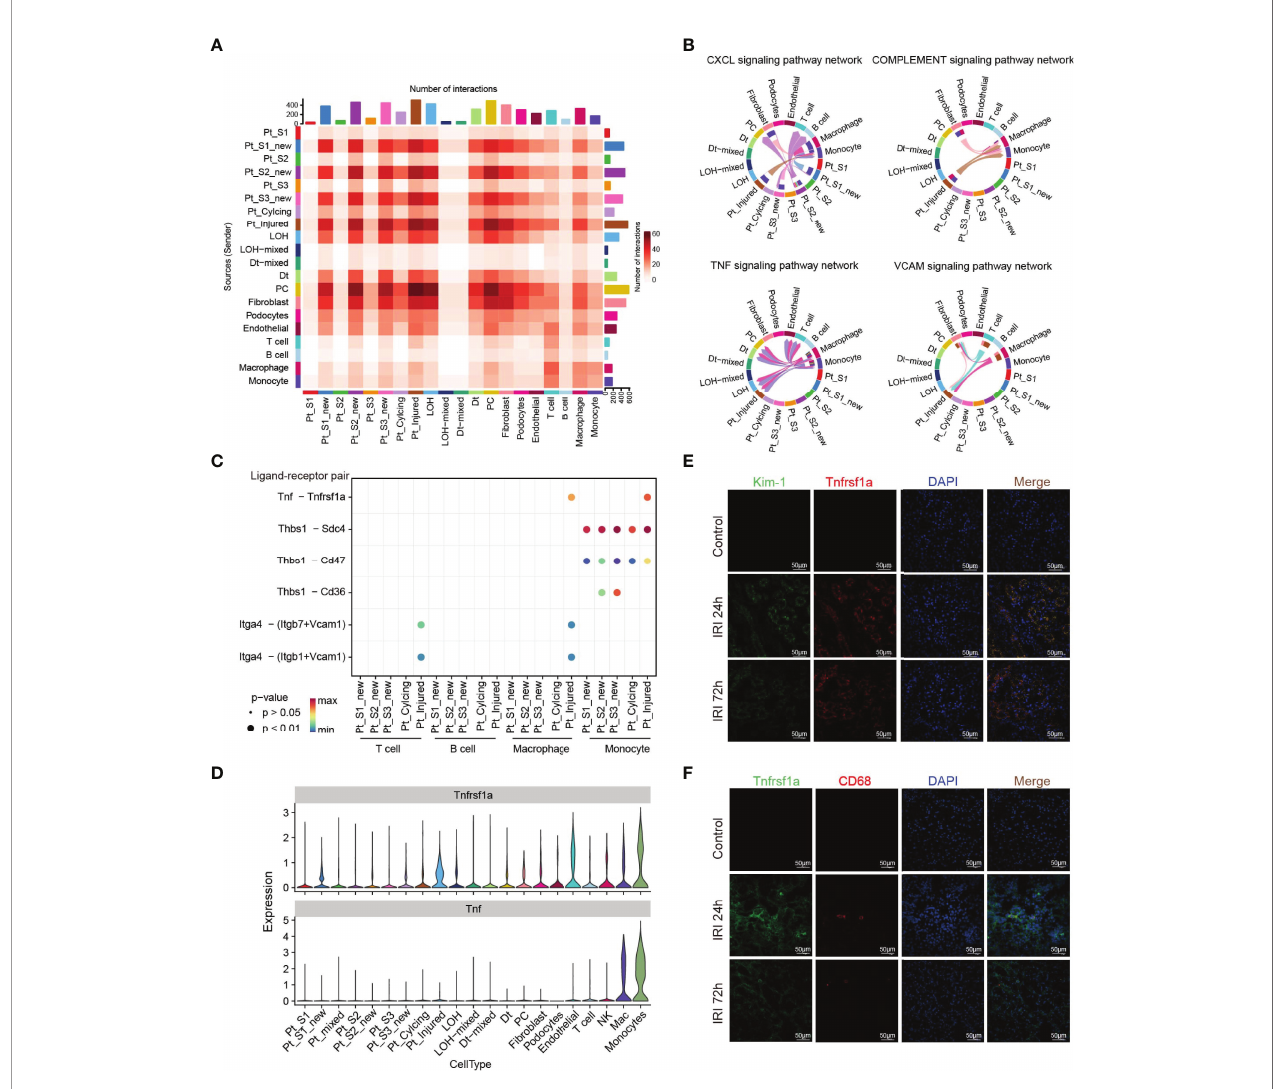
FIGURE 5 | Intercellular crosstalk analysis in AKI microenvironment. (A) Number of inferred interactions in 21 cell types. (B, C) Enriched immune signaling pathway networks (B – D) and signi fi cant ligand-receptor Tnf-Tnfrsf1a pair (C, D) in injured PTC, PTC-new and immune cells. (E) Immunostaining showing the spatial distribution of injured PTC marker Kim-1 and Tnfrsf1a alongside AKI timepoints. (F) Immunostaining showing the spatial distribution of CD68 expressing myeloid cells and Tnfrsf1a expressing PTCs alongside AKI